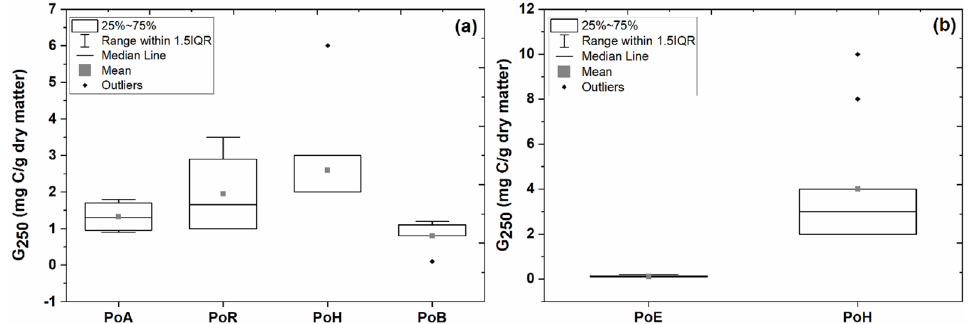
Figure 1. Cumulative carbon release after 250 days of degradation normalized to dry mass for mud samples ( a ) from different ports, and ( b ) from PoE and fluid mud samples from PoH. 1.5IQR, factor 1.5 of the interquartile range (25~75%).